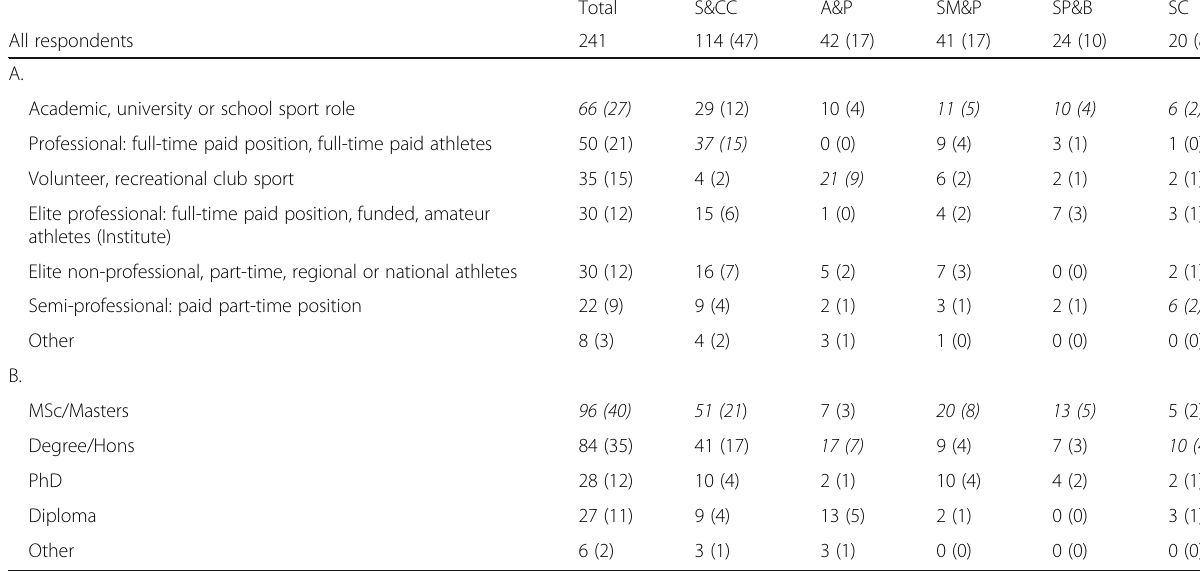
Table 1 (A) Employment and (B) education information presented for all respondents (total and